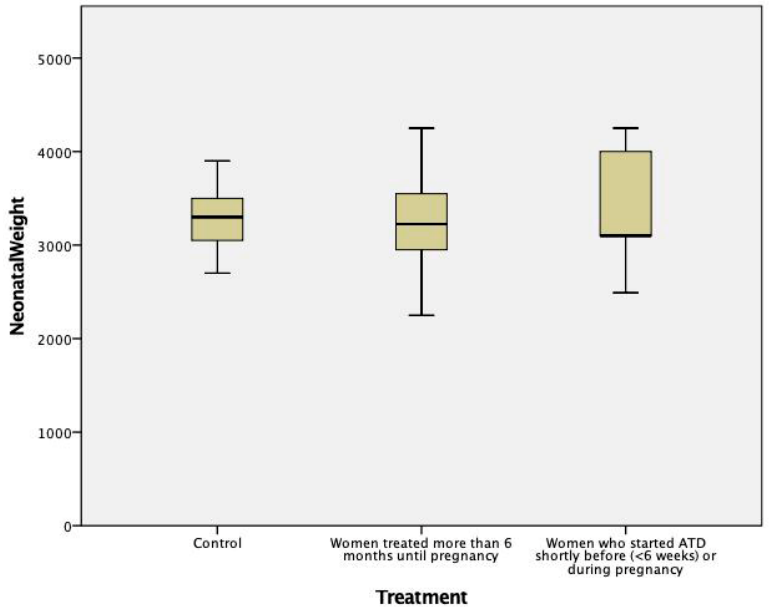
Figure 2. Newborn’s weight in mothers treated with ATD compared to healthy controls ( p = NS between groups) .